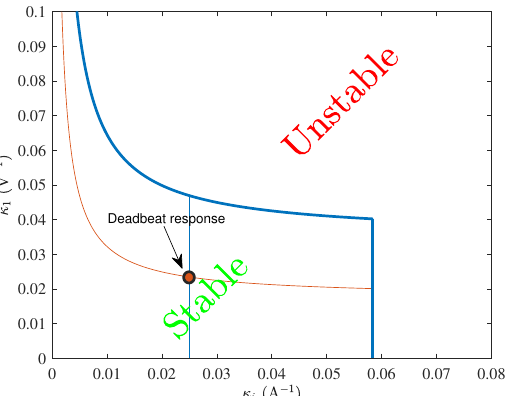
Figure 10. Stability region and optimum deadbeat response position in the parametric space. The left panel of Figure 11 shows the Floquet multipliers locus when the parameters are selected at the deadbeat response point in Figure 10. These multipliers are obtained from both the exact and the approximate monodromy matrix. As can predicted by the theoretical analysis, all the multipliers are located at the origin of the complex plane. The matching between the results in this particular case is also remarkable. The right panel of Figure 11 shows the corresponding system response to a 5% step change in the input voltage v g with the feedback. It can be observed that the duration of the transient after a perturbation in the input voltage takes place is three periods agreed with the theoretical prediction.